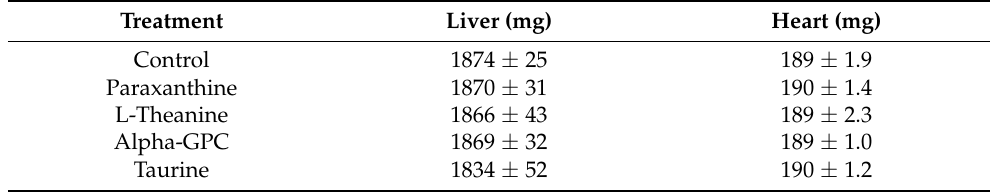
Figure 3. ( A ): Gastrocnemius mass (in milligrams) in mice after 28 days of supplementation. ( B ): Soleus mass (in milligrams) in mice after 28 days of supplementation. * = p < 0.05 vs. control, ** = p < 0.001 vs. control, # = p < 0.001 = vs. L-theanine, $ = p < 0.001vs. alpha-GPC ( p < 0.05), % = p < 0.001 vs. Taurine. Data represented by Mean ± SD ( n = 8 in each group). Table 6. Liver and heart mass in each group. Data represented by Mean ± SD ( n = 8 in each group). No changes were noted in all groups.